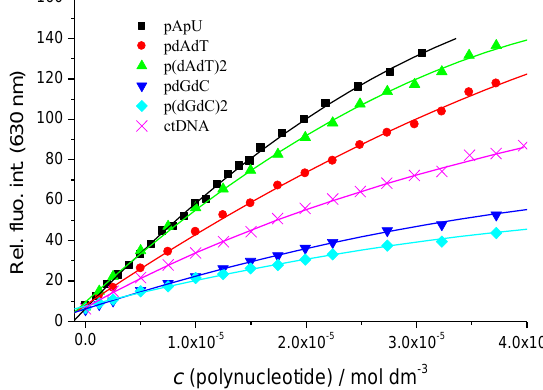
Figure 2. Strong increase of emission intensity of F1 ( c = 1 × 10 − 5 mol · dm − 3 , λ exc. = 541 nm) at λ em. = 630 nm upon the addition of various ds-polynucleotides (sodium cacodylate buffer, pH = 5.0, I = 0.05 mol·dm −3 ). Data were fitted by non-linear least square procedure according the Scatchard equation [29,30 ] ( ▬ ) and results are given in Table 2.